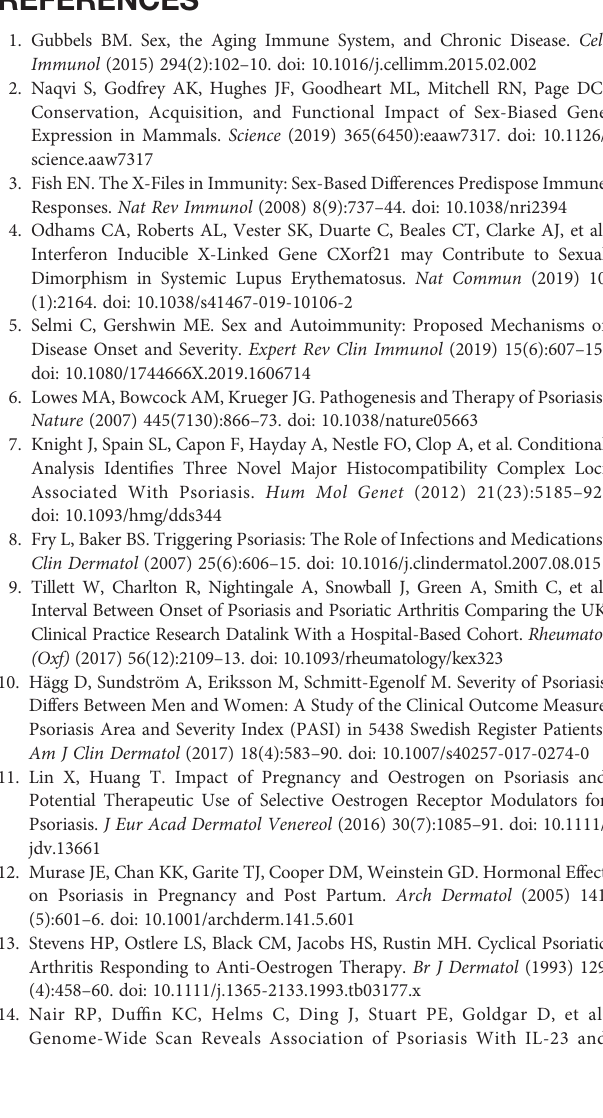
female, OVX, and sham operated as well as 17- b -estradiol treated mice with or without mannan application(n = 5/group). Man, mannan; MM, Man+ Male; MF, Man+ Female; MO,Man+OVX; MS,Man+ Sham; Mig,miglyol;E2, 17- b -estradiol. Statisticalanalyses wereperformedusinganunpairedttest.nindicatesnumberofmice.Thedatarepresent mean ± SEM. * p < 0.05; ** p < 0.01. *** p < 0.001. Supplementary Figure 5 | Immuno fl uorescence staining of CD11c + dendritic cells in the skin. (A) Immuno fl uorescence staining of CD11c + cells (green) in female and male mice in MISI (n = 3/group). Effect of (B) endogenous estrogen, (C) 17- b - estradiol, and (D) PHTPP or DPN on CD11c + dendritic cells (n = 3/group). Scale bar: 200 µm. Nuclei were counterstained with DAPI (blue). For quanti fi cation of immuno fl uorescence staining, mean fl uorescence intensity (MFI) of CD11c in the skin was calculated using Image J software in the above groups and the number of CD11c+ cells were counted manually. Man, mannan; NM, Naive Male; MM, Man + Male; NF, Naive Female; MF, Man + Female; PO, PBS + OVX; MO, Man + OVX; PS, PBS + Sham; MS, Man + Sham; Mig, miglyol; E2, 17- b -estradiol; Oil (P), E2 + Corn oil + Man; PHTPP, E2 + PHTPP +Man; Oil (D), Corn oil + Man; DPN, DPN + Man. Statistical analyses were performed using an unpaired t test and n indicates the number of mice used in each group. The data represent mean ± SEM. ns, not signi fi cant. * p < 0.05; ** p < 0.01. *** p <